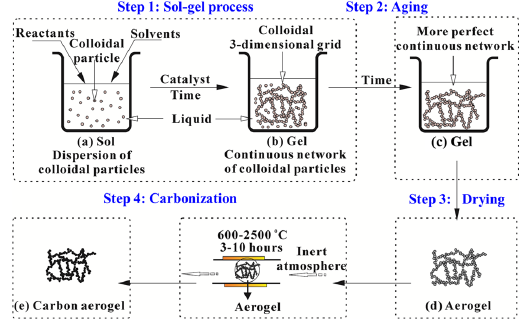
Figure 2. General preparation process of polymer or carbon aerogels.